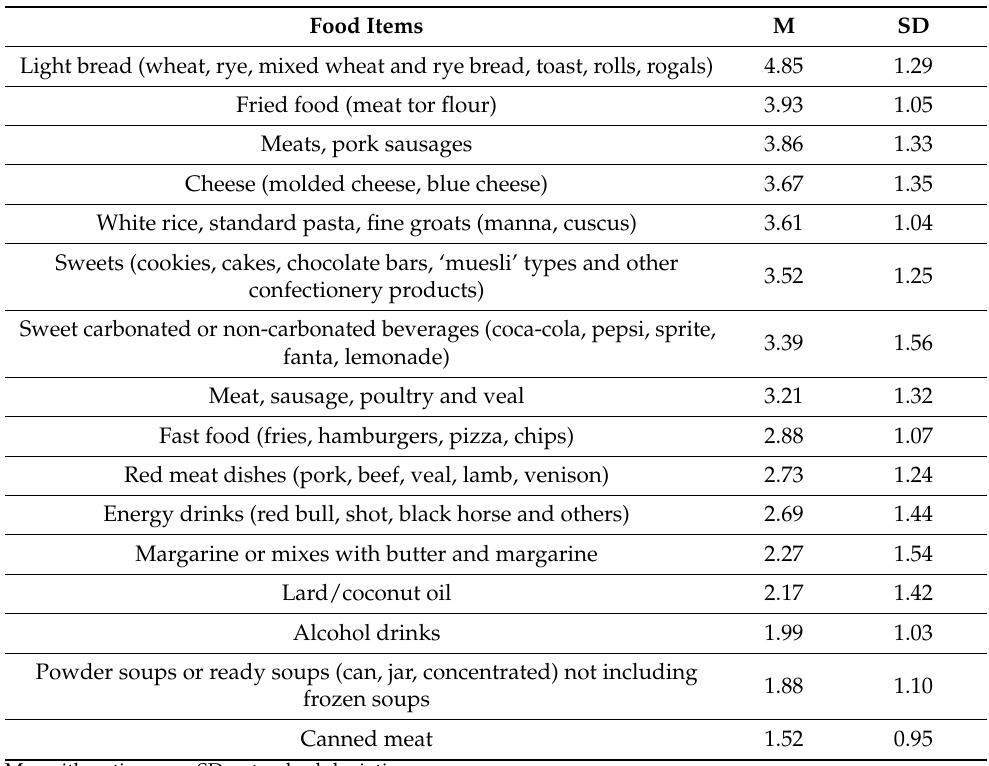
Table 2. The average consumption frequency (frequency/day) of food items negatively influencing brain